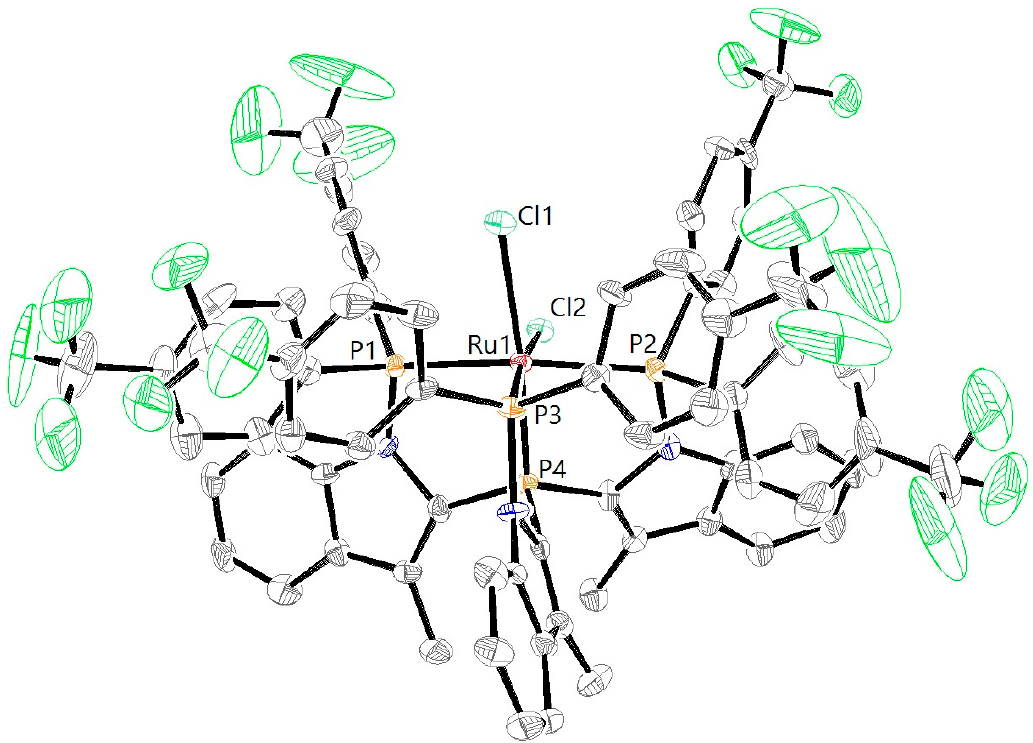
Figure 4. ORTEP drawing of RuCl 2 L1 CF3 (CCDC 1574141) showing one of the two rotamers. Thermal ellipsoids are set at 50% probability. Solvent molecules and hydrogen atoms have been omitted for clarity.